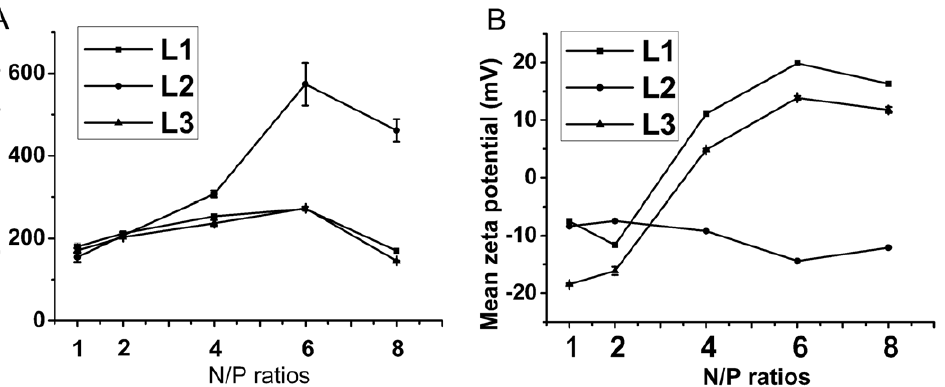
Figure 4. Particle sizes (A) and zeta-potentials (B) of lipid/DOPE/DNA complexes at different N/P ratios by DLS. All lipid/DOPE ratios were 1 : 2 and the concentration of DNA was 5 m g/well.